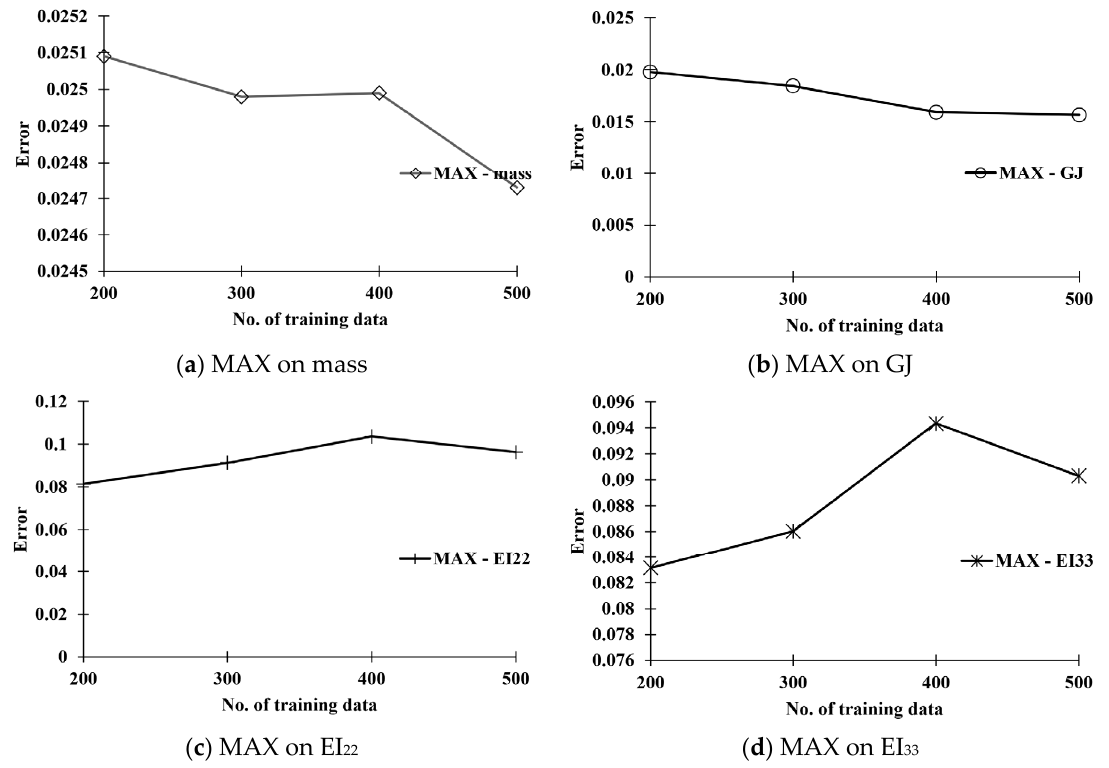
Figure 17. Maximum error according to variation of training data.